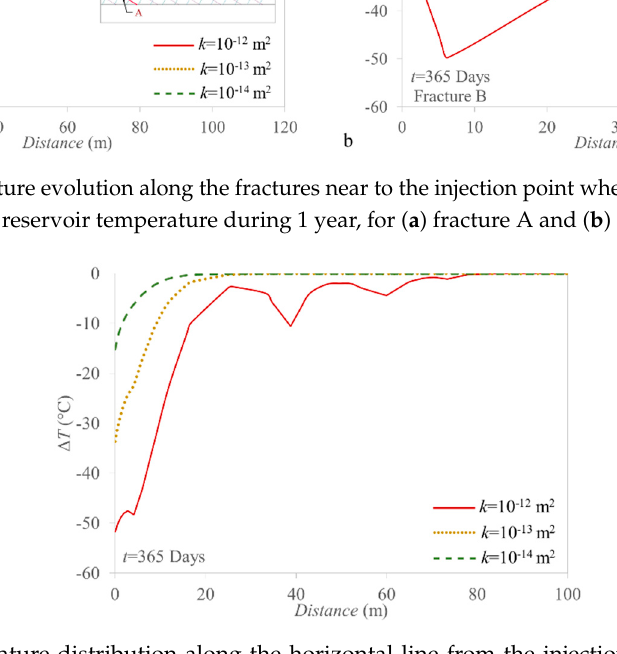
Figure 7. Temperature distribution along the horizontal line from the injection point after 1-year of injection.